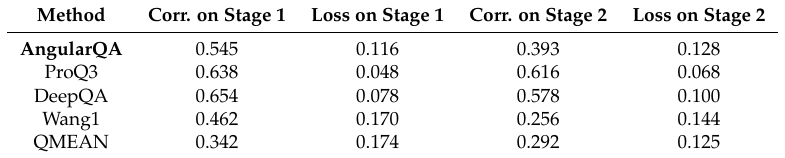
Table A7. Global score performances of AngularQA on CASP12 (Stage 1 and Stage 2)